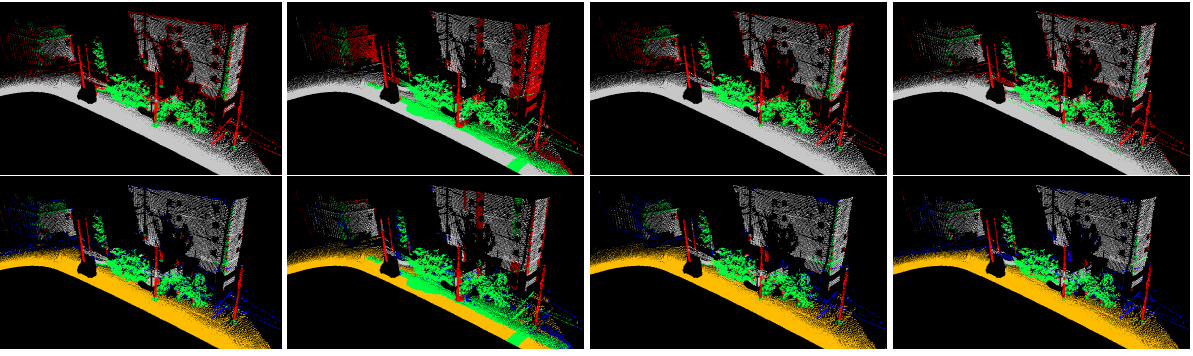
Figure 5. Classification results obtained for Oakland-3C (top row) and Oakland-5C (bottom row) when using the original point cloud, the neighborhood types N s, 1m , N c, 1m , N k =50 and N k (from left to right) and a Random Forest classifier. opt